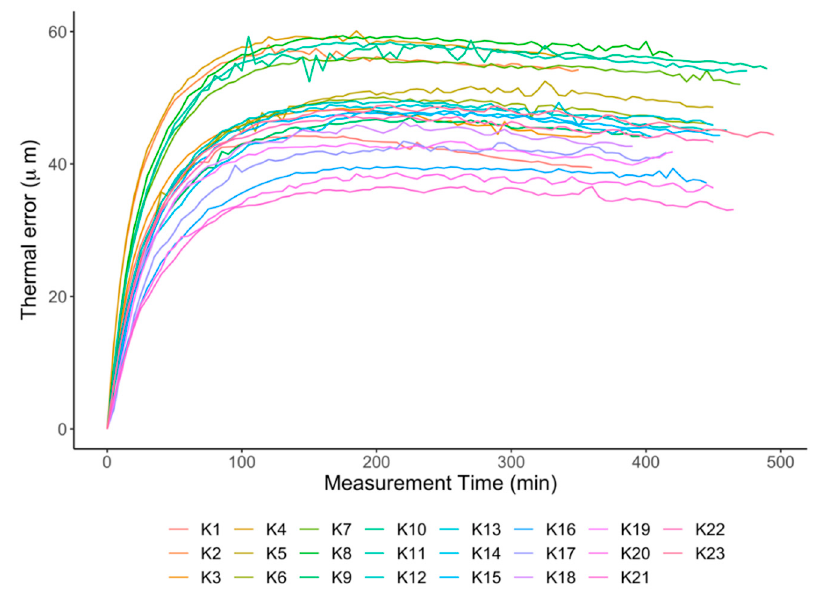
Figure 4. Thermal error curves in the Z direction of all 23 batches.